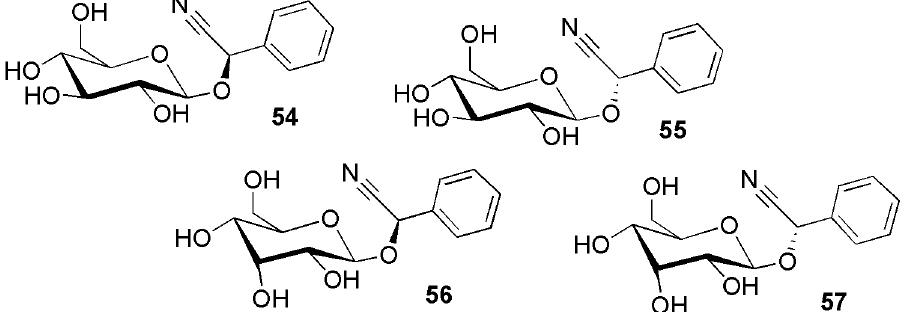
Figure 11. Cyanogenic glycosides group C-1, phenylalanine-derived cyanogenic glycosides 54 – 57 featuring a single, unsubstituted sugar moiety: ( R )-prunasin ( 54 ) and ( S )-sambunigrin ( 55 ) (2 R )-passiedulin ( 56 ) and (2 S )– β - D -allopyranosyloxy-2-phenylacetonitrile ( 57 ).